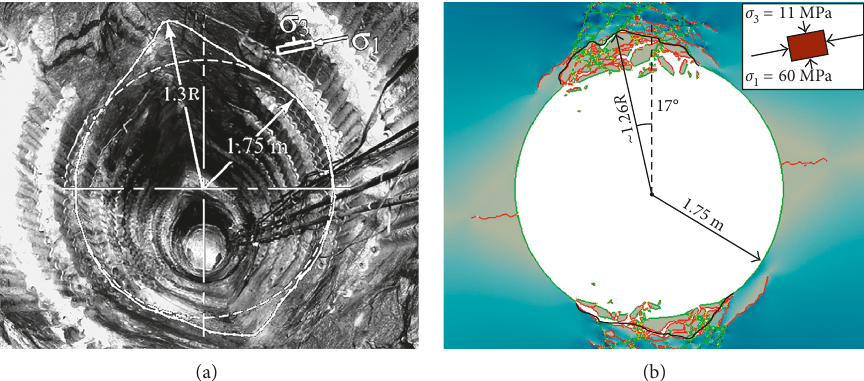
Figure 5: (a) Photograph of URL Test Tunnel (after [16] modified from [24]) showing the damage profile observed in situ. (b) Damage profile from the FDEM model (highlighted black) after the completion of the numerical analysis.